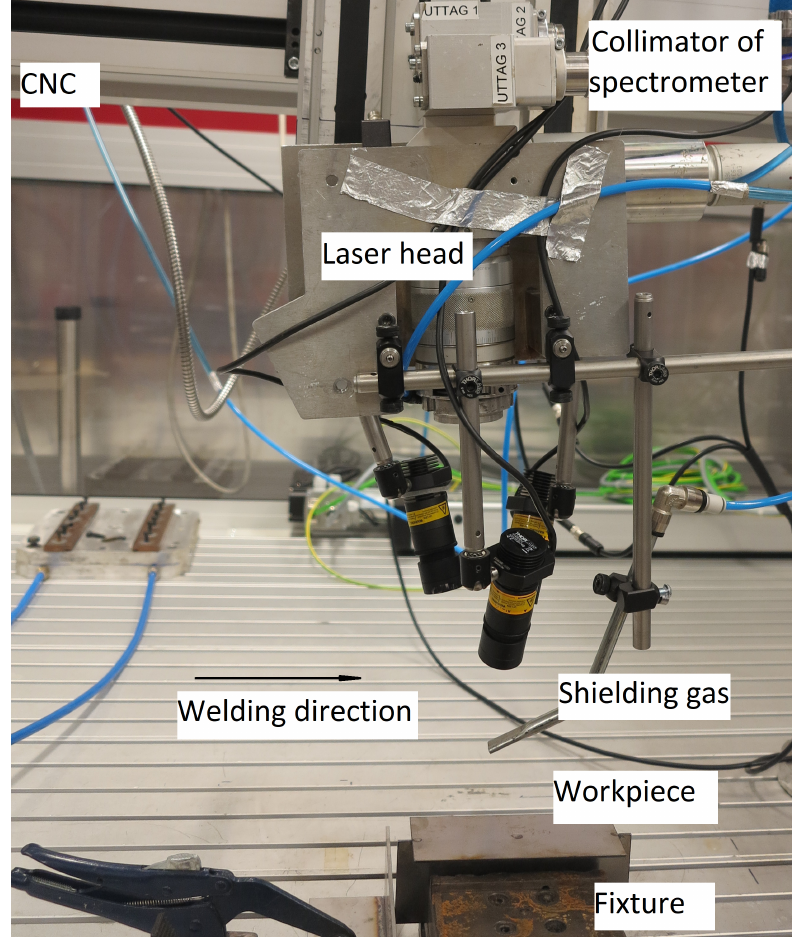
Figure 2. The welding setup for the